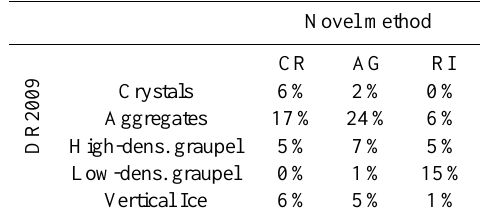
Table 5. As in Table 4 but comparing the classification of ice phase hydrometeor classes ( (cid:49)z > 0). The classes of the novel method are crystal (CR), aggregates (AG), and rimed-ice particles (RI). The el- ements M i,j of the matrix contain the percentage of ice phase ob- servations classified in the i th class of the first method and simulta- neously in the j th class of the second method. The data are obtained from 100 runs of the clustering